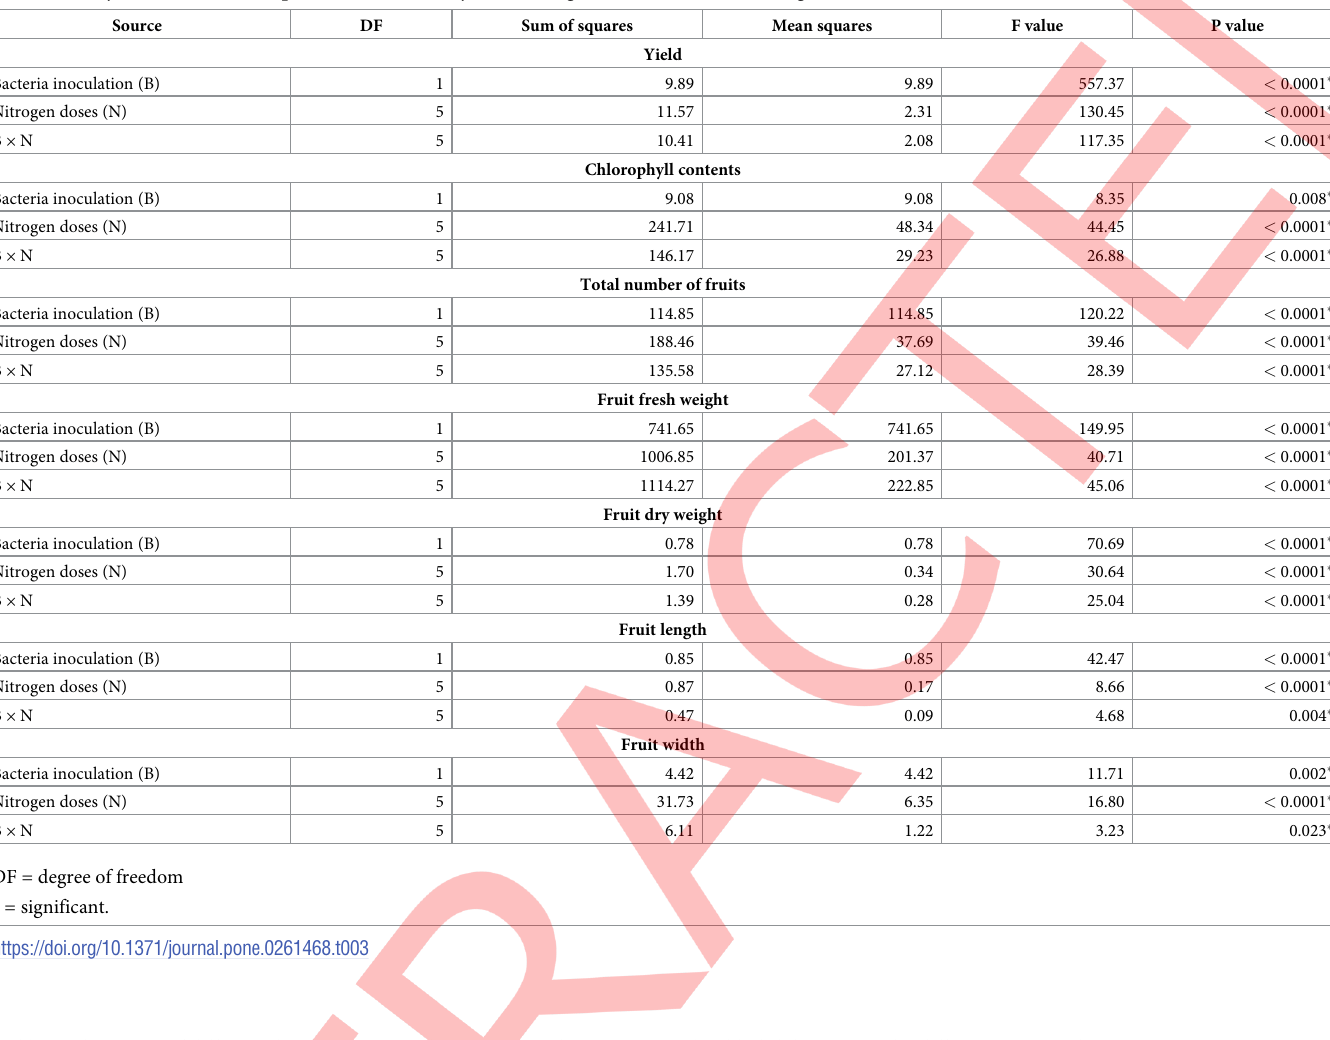
Table 3. Analysis of variance for reproductive traits and yield of chili grown under different nitrogen doses and bacterial inoculation. Source DF Sum of squares Mean squares